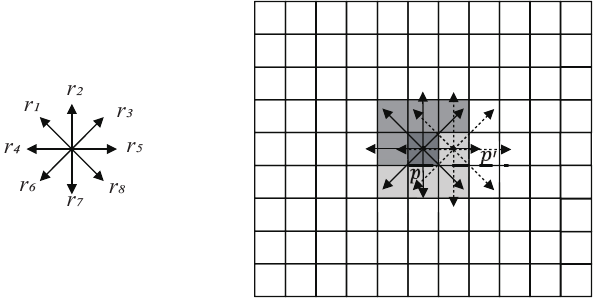
Figure 9. Demonstration of an 8-connection situation.